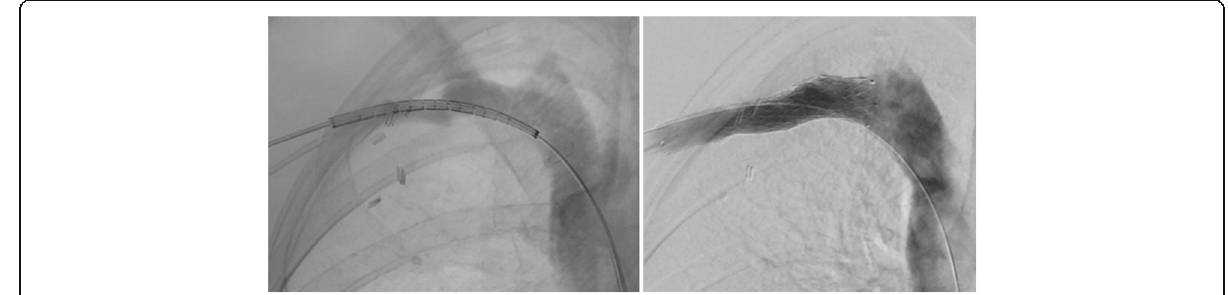
Fig. 4 Residual stenosis post angioplasty and result post